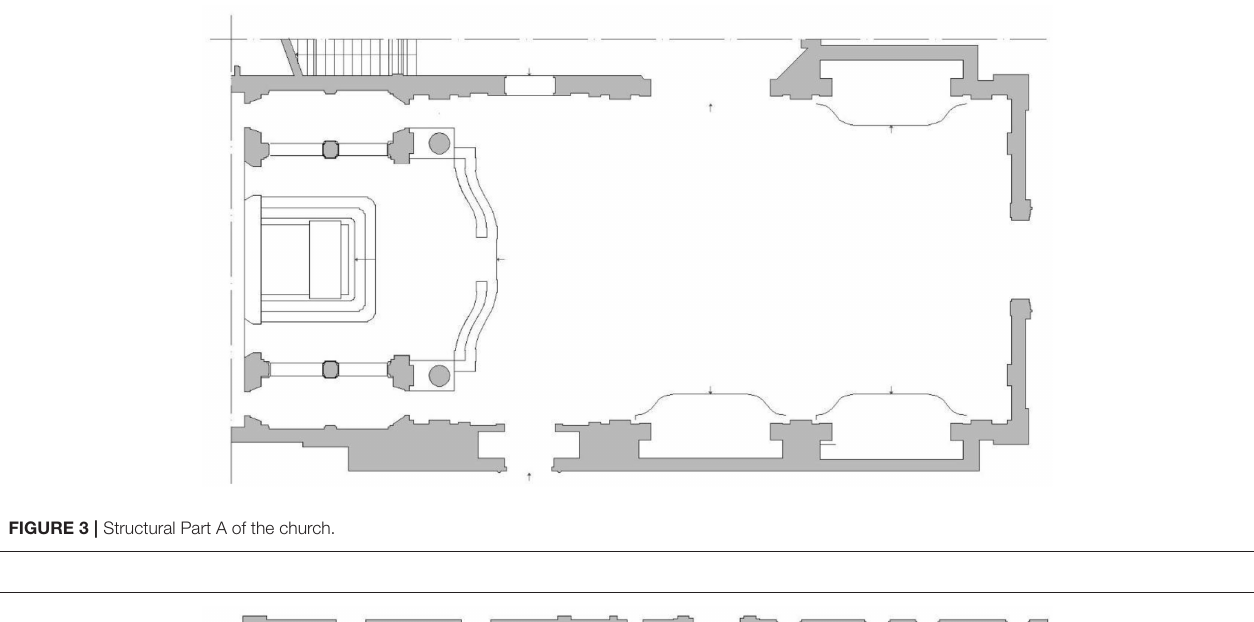
FIGURE 3 | Structural Part A of the church.